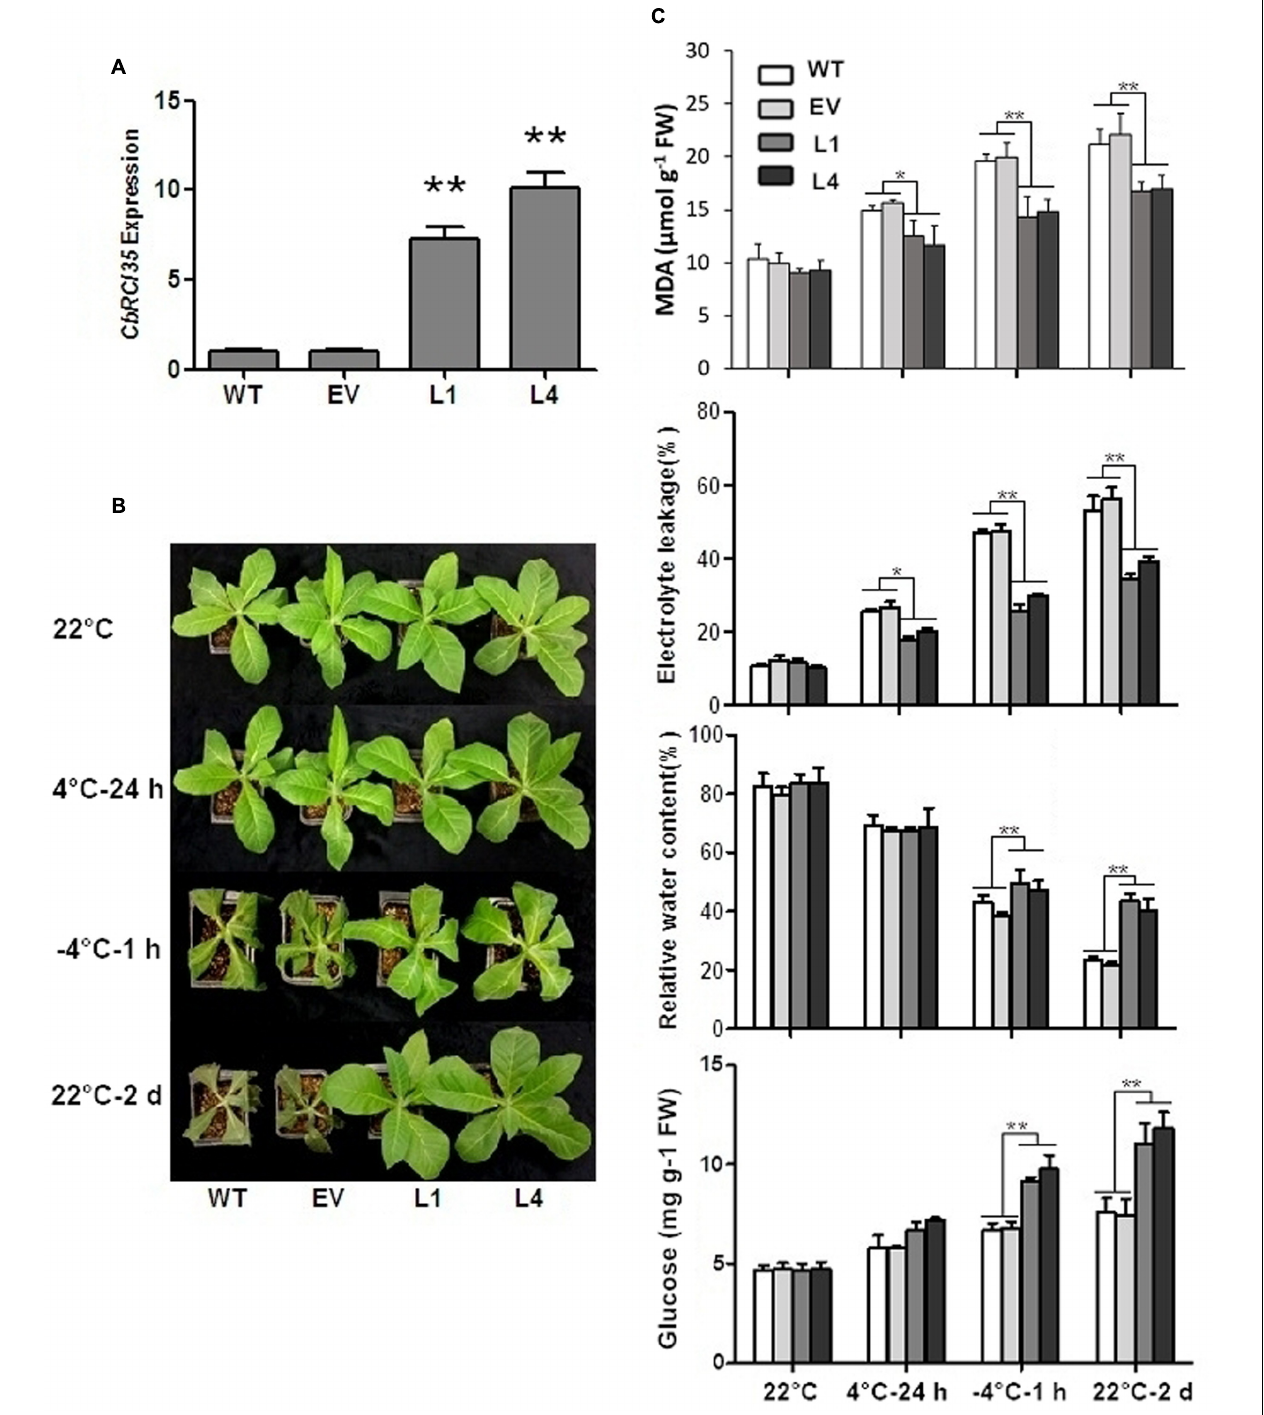
FIGURE 5 | CbRCI35 enhanced cold tolerance of tobacco plants. (A) The relative expression of CbRCI35 in transgenic tobacco plants. The NtActin gene was performed as an internal control. (B) Wild type (WT), empty vector control (EV) and CbRCI35-ox lines L1, L2 were grown at 22 ◦ C. After treated at 4 ◦ C for 24 h, at − 4 ◦ C for 1 h, and at 22 ◦ C for a 2-day recovery, plants phenotypes were shown. They were representatives of their respective types of tobacco plants. (C) The malondialdehyde (MDA) content, electrolyte leakage, relative water content and glucose content of tobacco leaves before and after cold application. Error bars indicate SD ( n = 3, ∗ P < 0.05, ∗∗ P < 0.01).